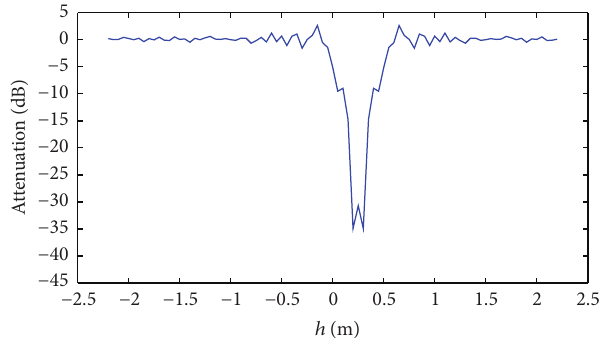
Figure10:Attenuationowingtopowerarchsupply(PAs)diffraction at Ku-band; the antenna diameter effect, line of sight (LOS) Italy parameters